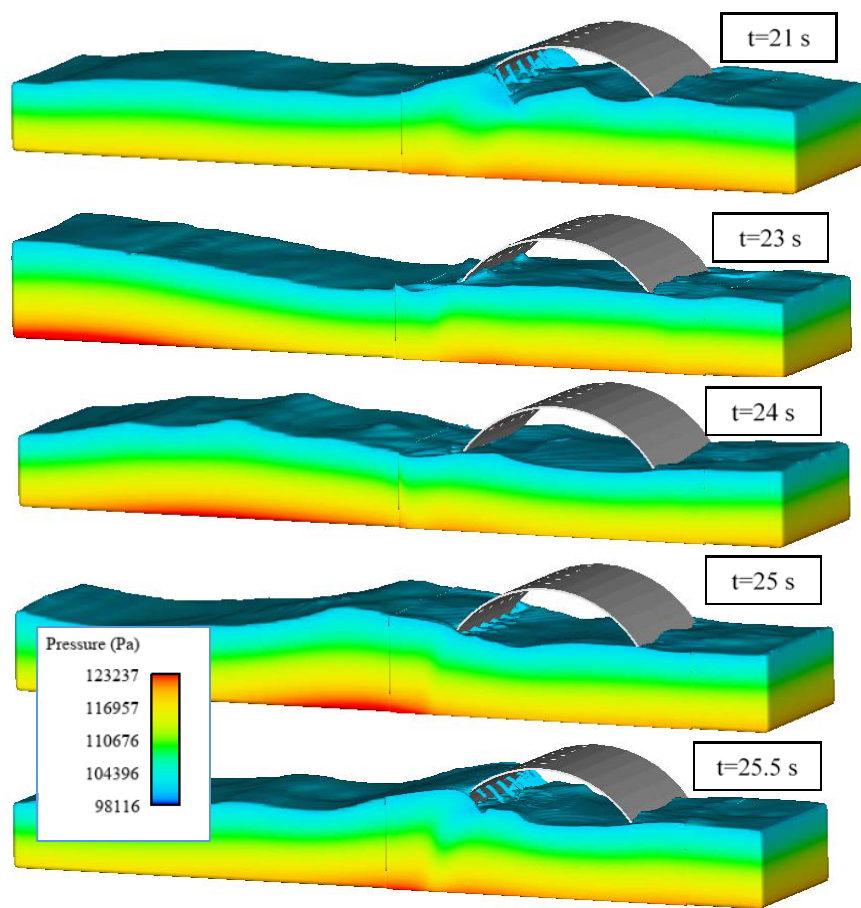
Figure 3. Results of pressure and free surface elevation at different instants for scenario 2.